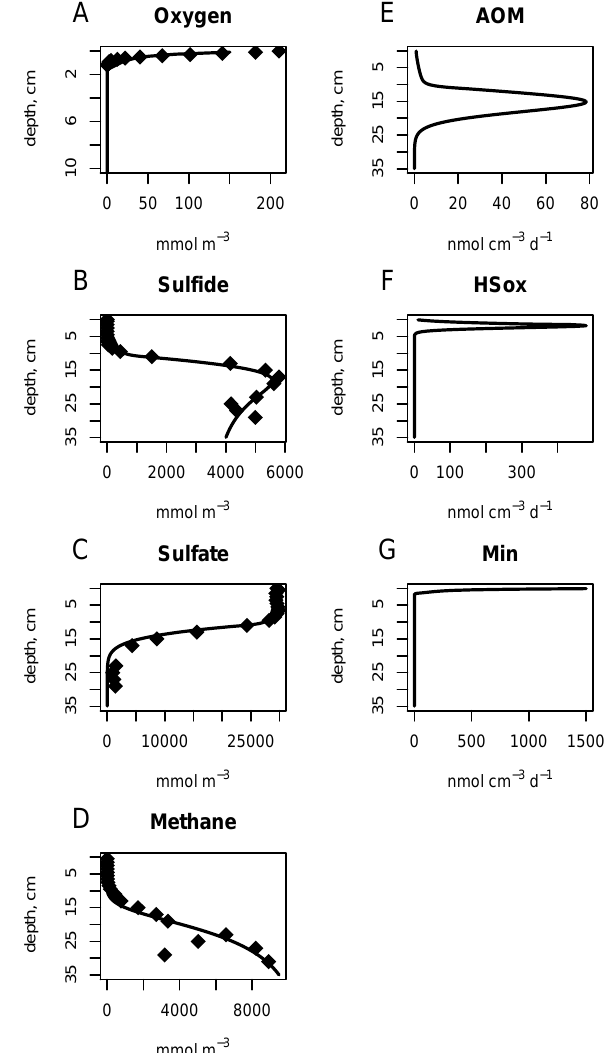
Fig. 3. (A–D) radially-averaged profiles of the concentrations of O 2 , HS − , SO 2 − , and CH 4 and the corresponding model fits. The 4 points are the data and the solid line is the model output. (E–G) Radially averaged profiles of the mean reaction rates. Units are in nmolScm − 3 d − 1 (E–F) or in nmolO 2 cm − 3 d − 1 (G) .